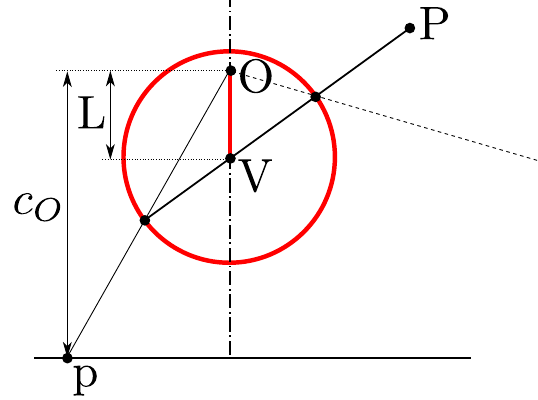
Figure 5: Catadioptric model according to Geyer and